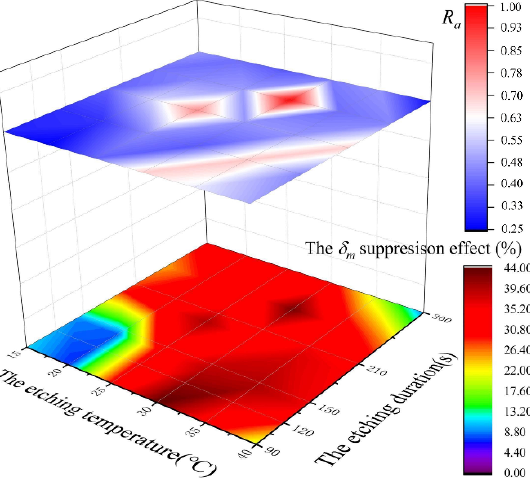
Figure 9. The relations among parameter schemes, corresponding morphologies and final SEY suppression